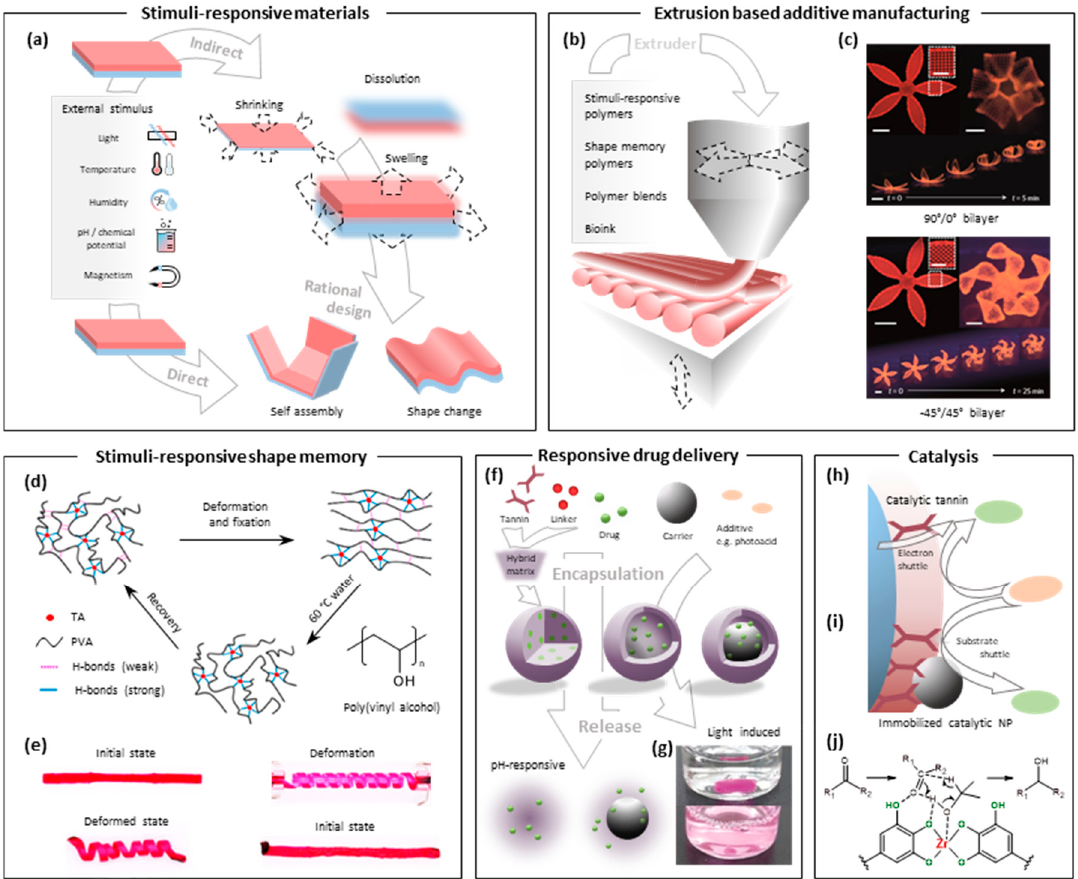
Figure 6. ( a ) Schematic representation of different types of stimuli and responses like swelling, shrinking and dissolution. Responses can directly result in complex shape change and self-assembly or